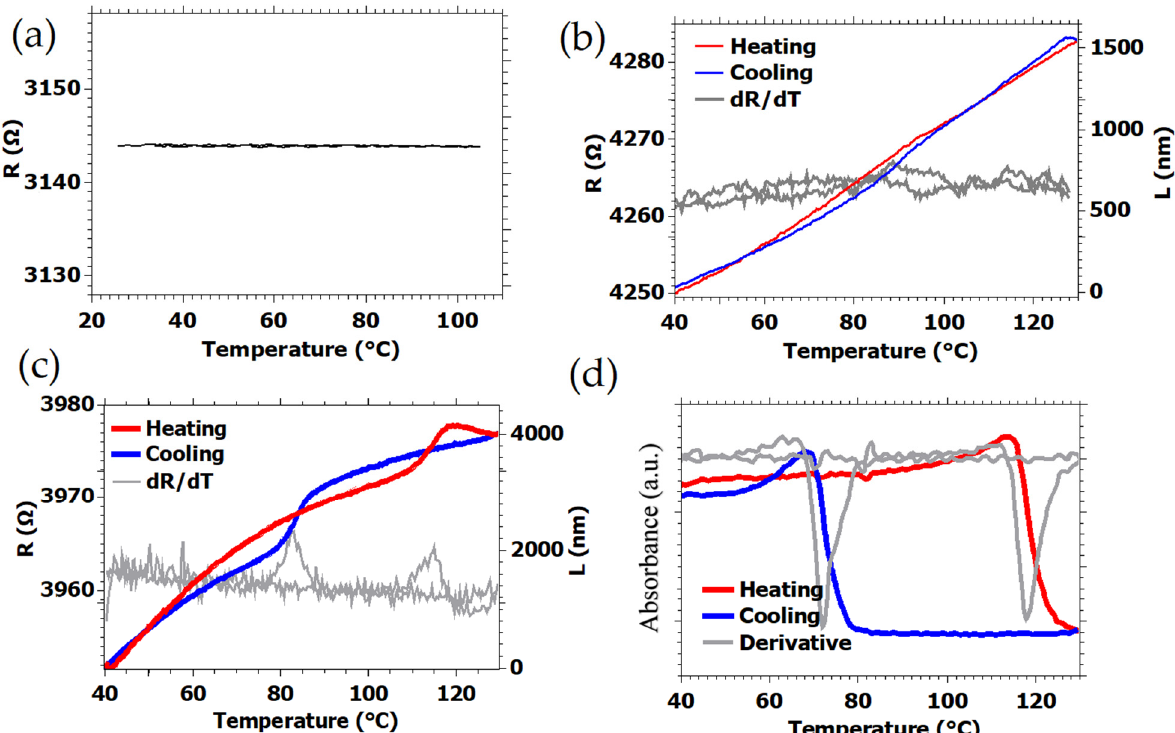
Figure 3. Actuating response upon heating and cooling of ( a ) an uncoated silicon micro-cantilever, ( b ) a microcantilever coated with a pure P(VDF-TrFE) film, and ( c ) a microcantilever coated with a [Fe(Htrz) 2 (trz)](BF 4 )@P(VDF-TrFE) composite film. In ( b , c ) both the measured static piezoresistance change ( left axis ) and the calculated tip deflection ( right axis ) are given and the derivative curves ( dR/dT vs. T ) are also plotted. ( d ) UV absorbance of a [Fe(Htrz) 2 (trz)](BF 4 )@P(VDF-TrFE) composite film recorded at 350 nm both for heating and cooling. The derivative curve ( dA/dT vs. T ) is also shown.